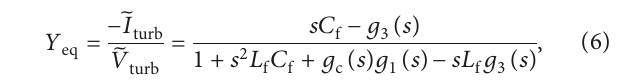
Figure 7: Block diagram of the the DC wind turbine converter (SRC#) in the closed-loop control with the output filter. Table 1: Parameters of the plant model of SRC#. Turns ratio of transformer ( N 1 : N 2 ) 1 :25